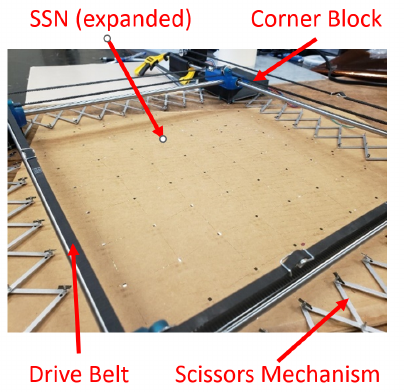
Figure 13. Post-stretch tool